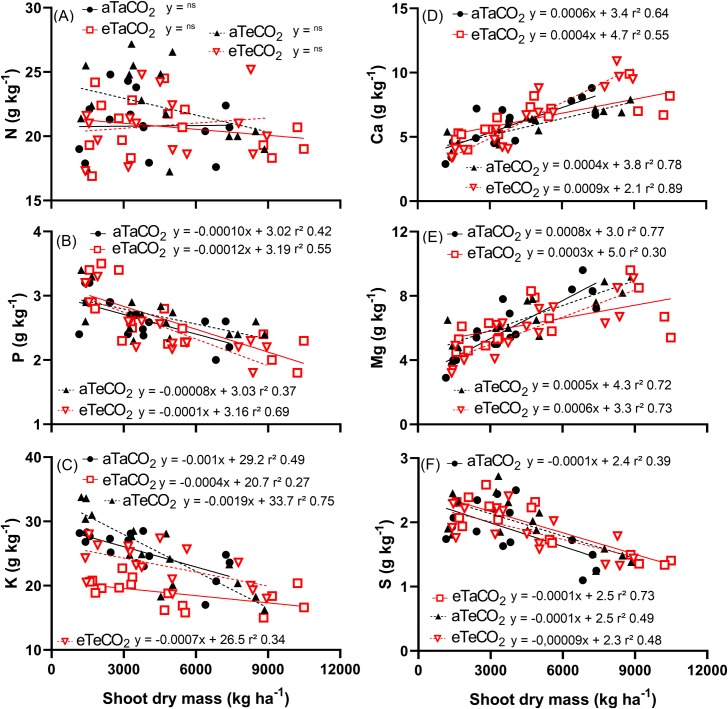
Linear regressions between N (A), P (B), K (C), Ca (D), Mg (E) and S (F) content and shoot dry mass of P. maximum. Treatments: aTaCO2 (ambient temperature and ambient [CO2]), eTaCO2 (2°C above ambient temperature and ambient [CO2]), aTeCO2 (ambient temperature and 200 ppm above ambient [CO2]), and eTeCO2 (2°C above ambient temperature and 200 ppm above ambient [CO2]).